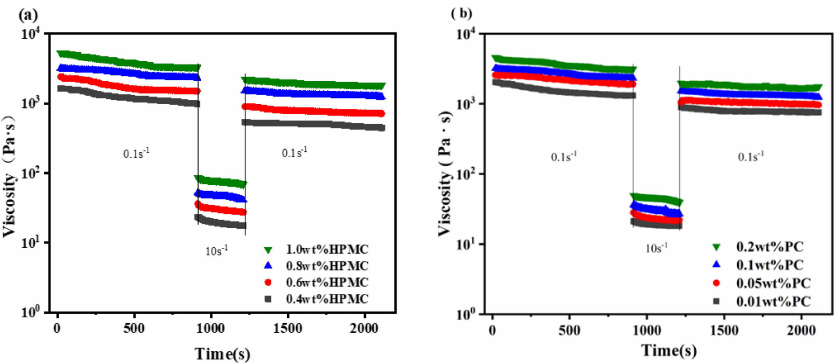
Figure 6. Time sweep ( a ) curves for oleogels prepared by different HPMC concentrations and a constant PC concentration (0.1 wt%). Time sweep ( b ) curves for oleogels prepared by different PC concentrations and a constant HPMC concentration (0.8 wt%). (HPMC—Hydroxypropyl methylcel- lulose,